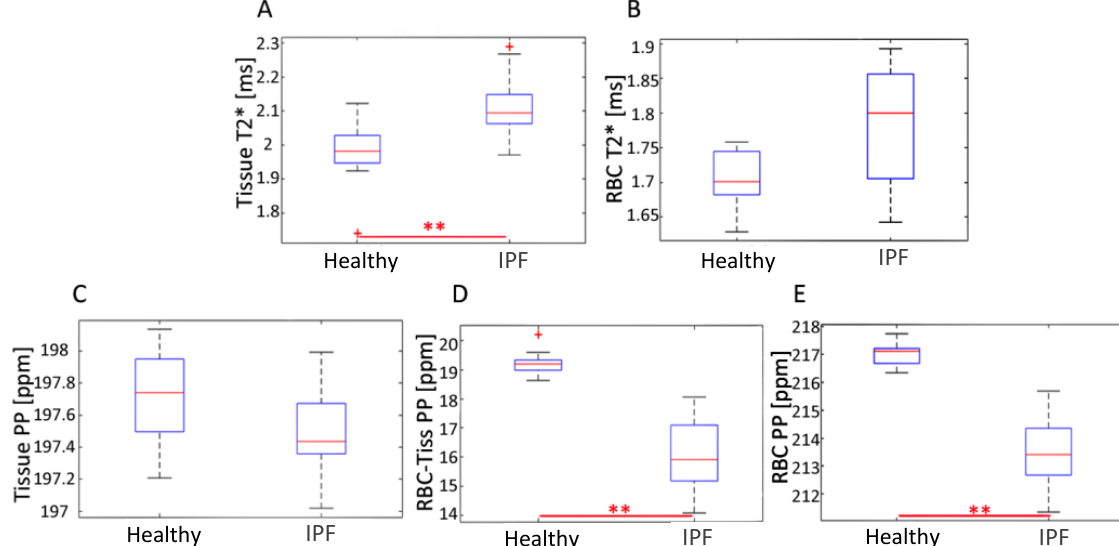
Figure 6. Distribution of average ( A ) Tissue T 2 *, ( B ) RBC T 2 *, ( C ) Tissue CS, ( D ) RBC-Tissue CS and ( E ) RBC CS for healthy and IPF subjects. ** represents p < 0.01.